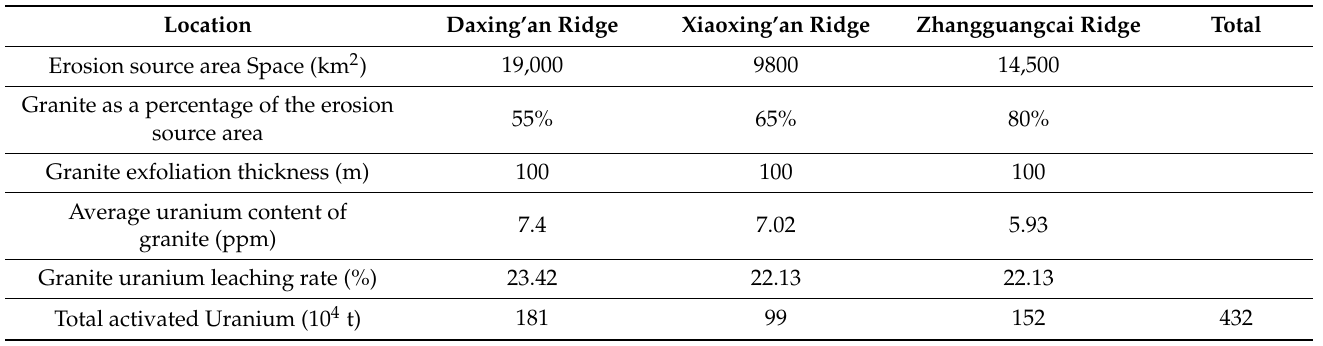
Table 2. Calculation of the total amount of activated uranium remitted to the basin from uranium-bearing granite alteration source areas in the northern part of the Songliao Basin (after